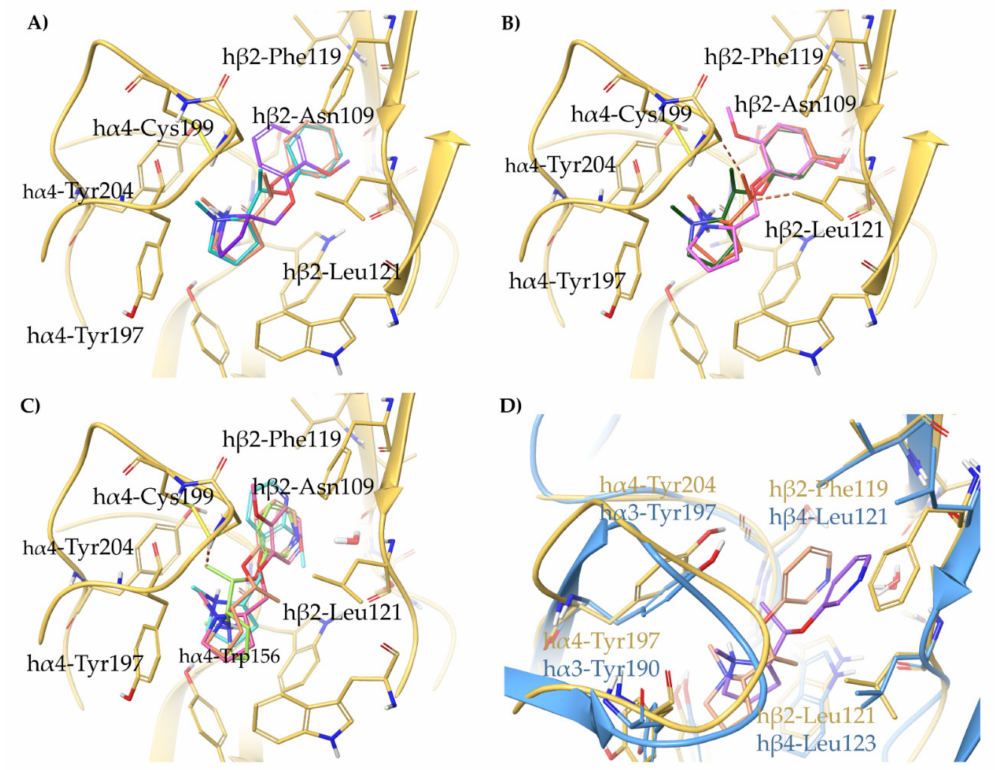
Figure 7. Receptor backbone and residues are depicted in yellow (h α 4 β 2) and light blue (h α 3 β 4). Unfavourable steric clashes are represented with orange dashed lines. Proposed binding modes at h α 4 β 2 nAChR (adapted from 6CNJ) of the ( A ) semirigid non-hydroxylated phenyl ethers ( S )- 8 (purple), ( S , R )- 10 (cyan), and ( S , S )- 10 (faded orange); ( B ) semirigid hydroxylated phenyl ethers ( S )- 9 (pink), ( S , R )- 11 (dark green), and ( S , S )- 11 (orange); and of ( C ) semirigid piridyl ethers ( S )- 12 (light cyan), ( S )- 13 (faded pink), ( S , R )- 14 (faded orange), and ( S , S )- 14 (yellow-green). ( D ) Comparison of the binding modes of ( S , R )- 14 at the h α 4 β 2 (ligand faded orange) and at the h α 3 β 4 (ligand faded purple)